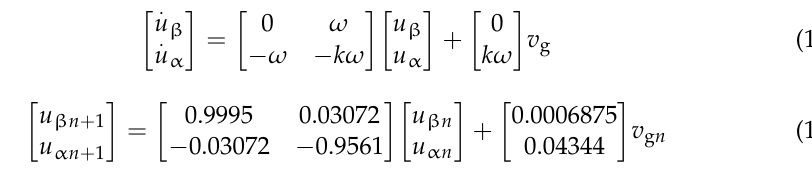
Figure 9. 3CH4 current source inverter grid-connected control block: ( a ) PI control with grid voltage feed-forward; ( b ) PI control with AD & PD grid voltage feed-forward.